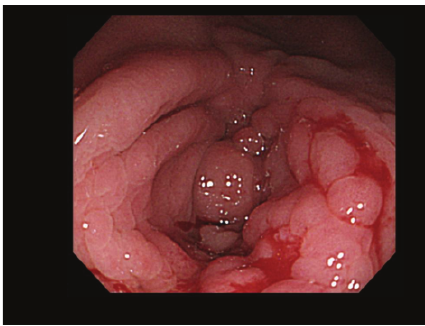
Figure 1: Photograph of lower endoscopic examination. A lon- gitudinal ulcer scar, a cobblestone appearance, and stenosis were observed at the hepatic flexure.